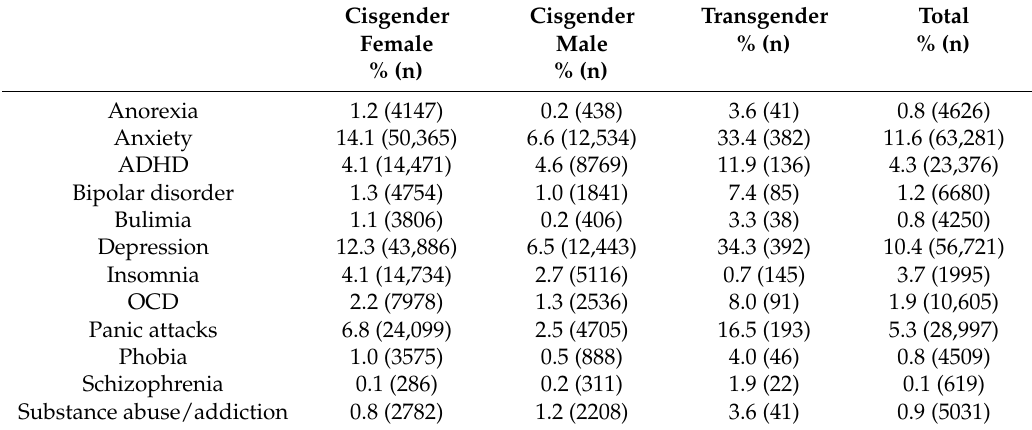
Table 1. Percentage of students diagnosed/treated in last 12